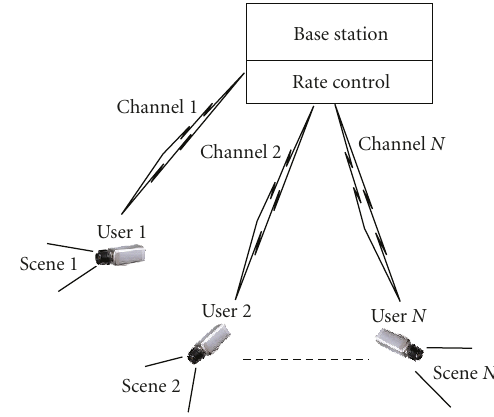
Figure 1: Network of wireless video